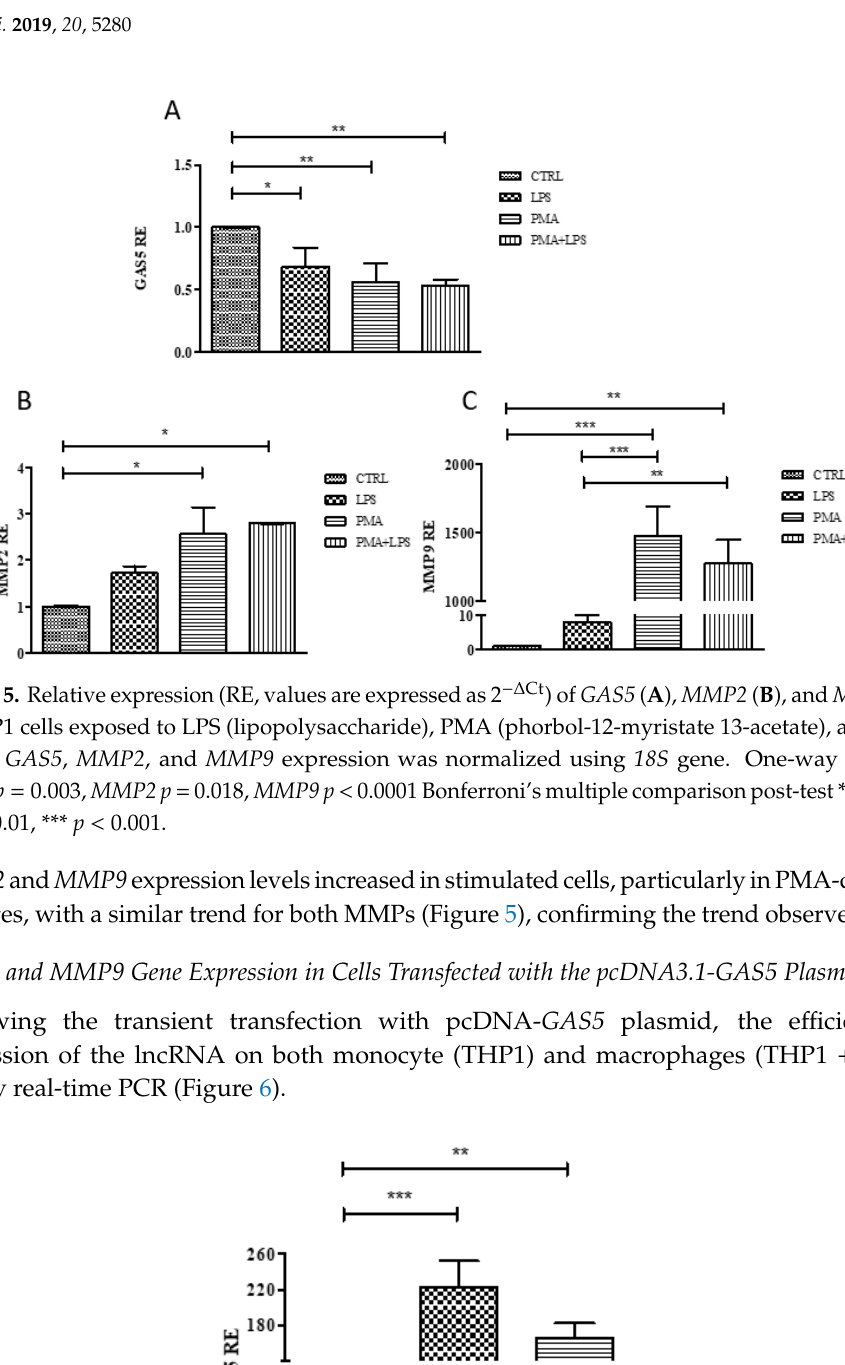
Figure 7. Levels of MMP2 ( A ) and MMP9 ( B ) after overexpression of GAS5 (GAS5) in monocyte stimulated with LPS (LPS) and macrophages stimulated with LPS (PMA + LPS) and in controls (EMPTY). MMP2 and MMP9 expression were normalized using GAPDH gene and relative expression (RE) values are expressed as 2 −ΔΔ Ct . Two-way ANOVA: EMPTY vs. GAS5 MMP2 p = 0.002, MMP9 p < 0.0001 Bonferroni’s multiple comparison post-test * p < 0.05, ** p < 0.01, *** p < 0.001. 2.6. MMP2 and MMP9 Proteins Released by THP1 Cells Overexpressing GAS5 To confirm the role of GAS5 in regulating the expression of MMP2 and MMP9 , their levels in the supernatant of both LPS-stimulated monocytes and PMA-differentiated macrophages overexpressing GAS5 were evaluated by enzyme-linked immunosorbent assay (ELISA) test. As reported in Figure 8, MMP9 was less expressed in GAS5 -transfected monocytes with respect to the control; no difference was detected measuring MMP2 levels. Overexpressing GAS5 significantly downregulated both MMP proteins in macrophages stimulated with LPS compared to the cells transfected with the empty vector (Figure 8).